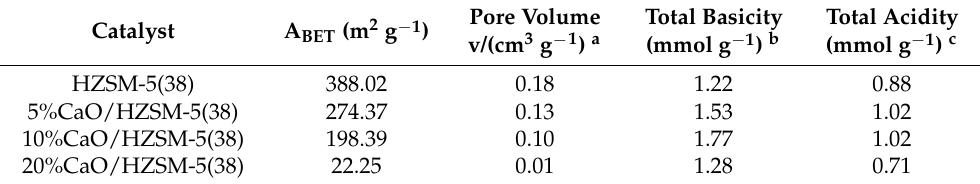
Figure 2. N 2 adsorption–desorption isotherms of the 20%CaO/HZSM-5(38), 10%CaO/HZSM-5(38), 5%CaO/HZSM-5(38) and HZSM-5(38) catalysts. Table 1. Structural parameters of fresh catalysts.